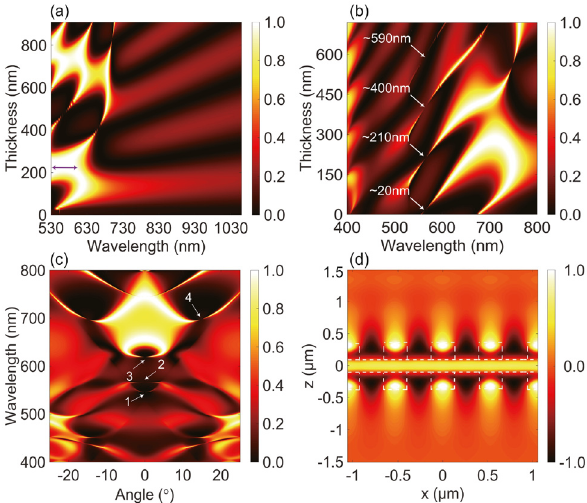
Figure 3: Reflectance spectra mapping and electric field distribution